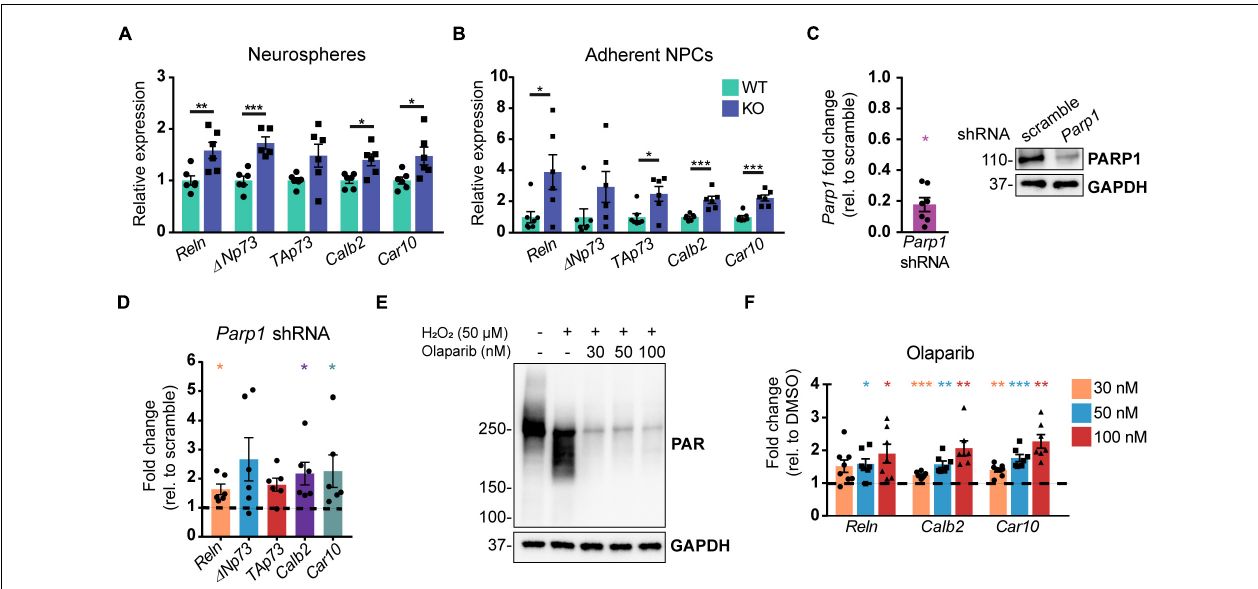
FIGURE 5 | Poly (ADP-ribose) polymerase 1 loss by KO, shRNA knockdown, or pharmacological inhibition increases mRNA levels of genes expressed by Cajal–Retzius cells. (A,B) Quantitative RT-PCR for genes expressed by CR cells in neurospheres (A) and adherent NPCs (B) from WT and KO cultures ( n = 6 of each genotype) demonstrate increased expression of genes expressed by CR cells. Target mRNA levels were normalized to Rpl19 . * p < 0.05; ** p < 0.01; *** p < 0.001 by Student’s unpaired t -test. Relative WT versus KO expression of TAp73 in (A) is p = 0.06 and of (cid:49) Np73 in (B) is p = 0.01. (C) Parp1 transcript (left) and protein (right) levels are substantially reduced following transduction of wild-type NPCs with Parp1 shRNA expressing lentivirus. Fold change in transcript levels was calculated relative to scramble (scr) shRNA control ( n = 7). Parp1 expression was normalized to Gapdh . * p = 0.0156 by Wilcoxon test. (D) mRNA transcripts expressed by CR cells are increased after wild-type NPC transduction with Parp1 shRNA-expressing lentivirus (MOI 3) for 72 h. Gene expression was normalized to Gapdh. Fold change relative to scramble (scr) shRNA-transduced NPCs is plotted ( n = 6); (cid:49) Np73 and TAp73 : p = 0.06; * p = 0.0313 by Wilcoxon test. (E) PAR western blot of wild-type NPCs after Olaparib pre-treatment (at indicated concentrations) for 1 h followed by 10 min H 2 O 2 treatment (50 µ M) shows that Olaparib inhibits H 2 O 2 -induced PARylation. (F) Olaparib-mediated inhibition of PARP1 in wild-type NPCs for 48 h increases mRNA levels of genes expressed by CR cells. Gene expression was normalized to Rpl19 . Fold changes were calculated relative to DMSO control treated cells ( n = 7–8). Reln (30 nM): p = 0.056; * p < 0.05; ** p < 0.01; *** p < 0.001 by repeated measures one-way